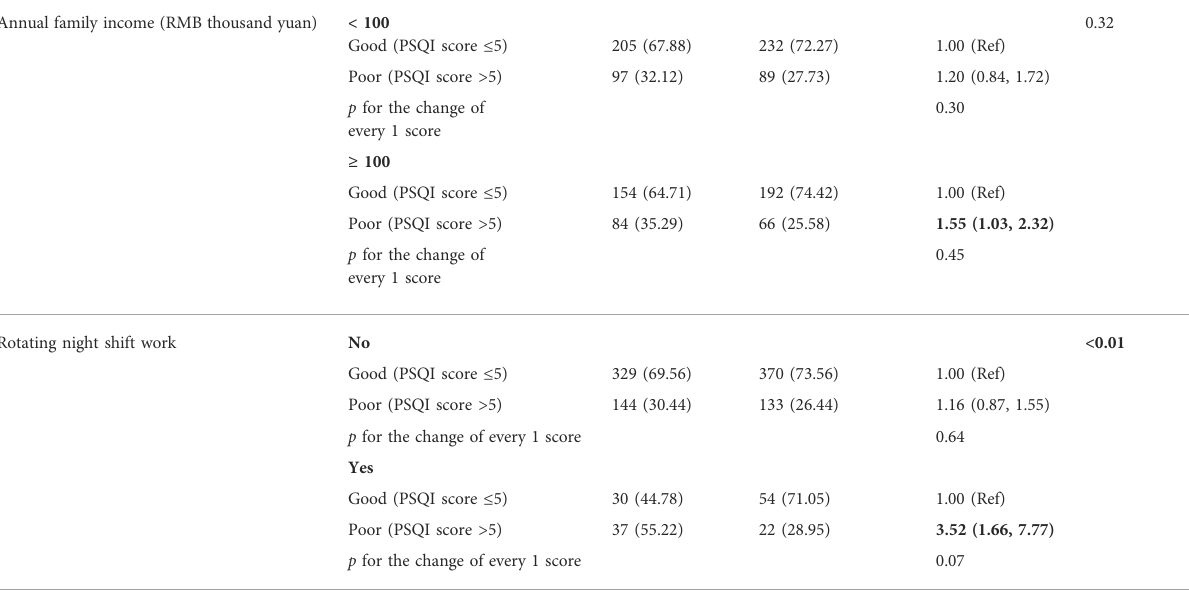
TABLE 3 ( Continued ) Subgroup analyses of the associations between sleep quality and asthenozoospermia